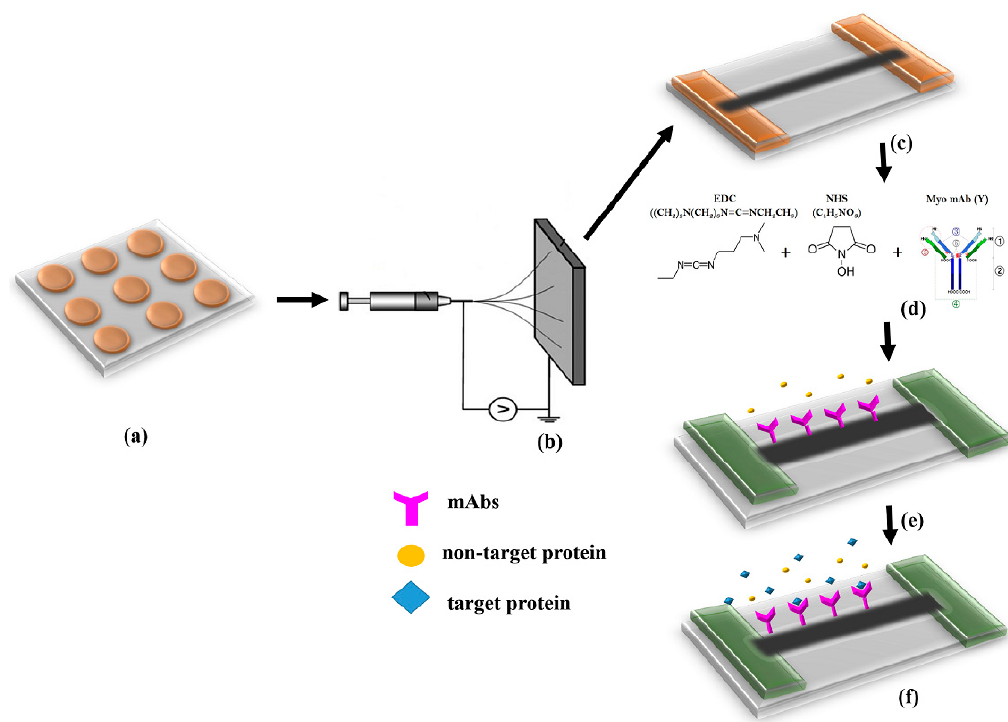
Figure 2. Schematic illustration of functionalized MWNCT-embedded SU-8 nanofibers for detection of myoglobin. ( a ) Microelectrode Array; ( b ) Electrospinning set-up; ( c ) Aligned nanofiber between electrodes; ( d ) EDC, NHS Chemistry for Antibody Immobilization; ( e ) Myoglobin Antibody immobilized onto nanofiber; ( f ) Binding of Myoglobin onto the nanofiber.